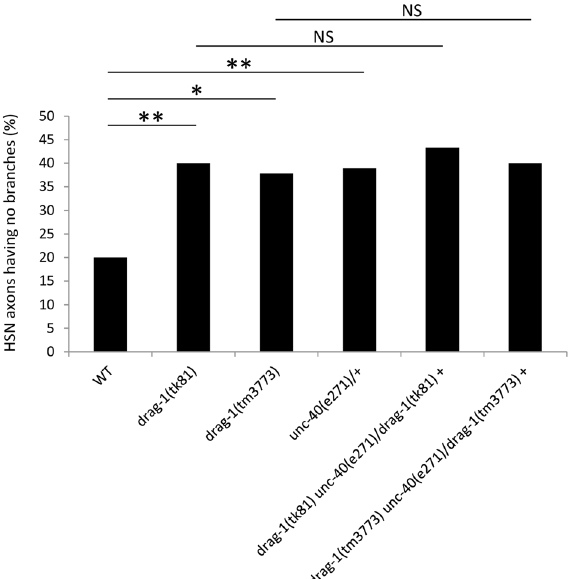
Figure 7. drag-1 does not enhance unc-40/+ with respect to HSN branching defects. Percentages of HSNs having no branches are shown. drag-1(tk81) and drag-1(tm3773) mutants were compared with unc- 40(e271)/+ heterozygotes and with drag-1(tk81) unc-40(e271)/+ and drag-1(tm3773) unc-40(e271)/+ double mutants. Significant differences were determined by Fisher’s exact test. **P < 0.01, *P < 0.05. NS not significant. n = 90 for each